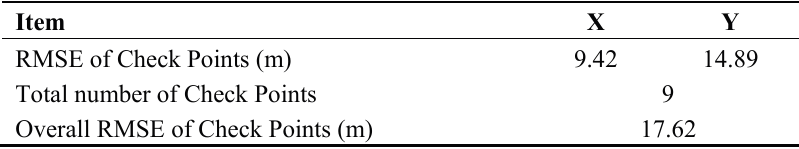
Table 2. The external accuracy of historical aerial